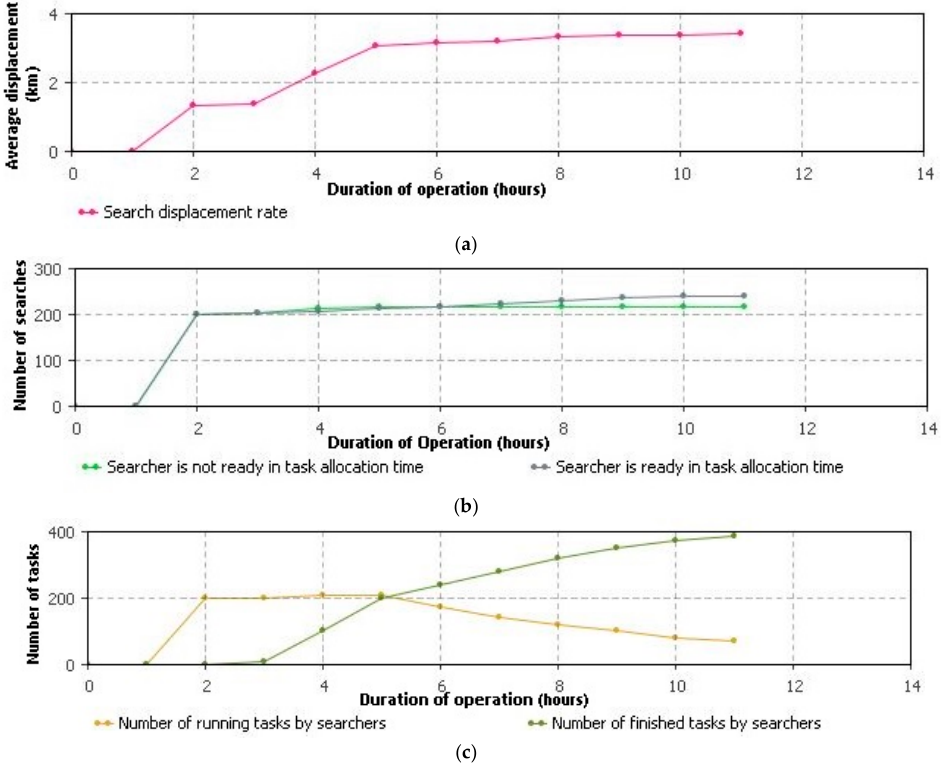
Figure 6. Instantaneous statistics for search agents at moment t 1 , ( a ) the distance traveled by the search agents, ( b ) ready search agents during the operations, ( c ) the number of injuries in the search phase or passed the phase.